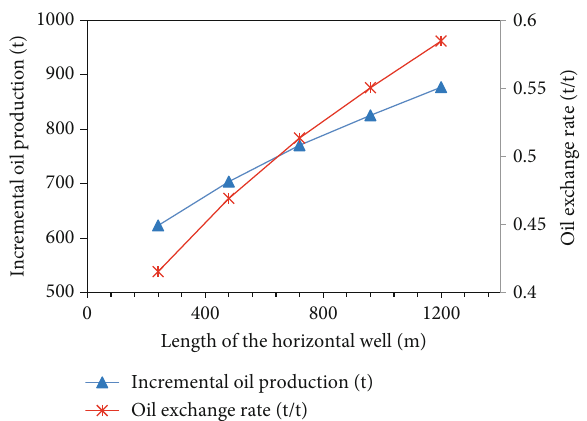
Figure 11: Incremental oil production and oil exchange rate through CO hu ff -n-pu ff under di ff erent horizontal well lengths. 2